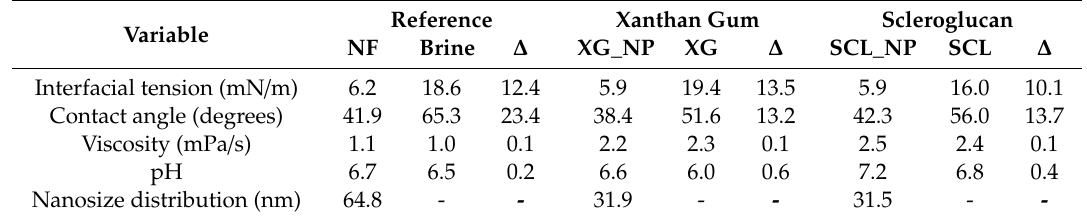
Table 7. E ff ect of the NPs in the performance of the biopolymer solutions at room temperature.